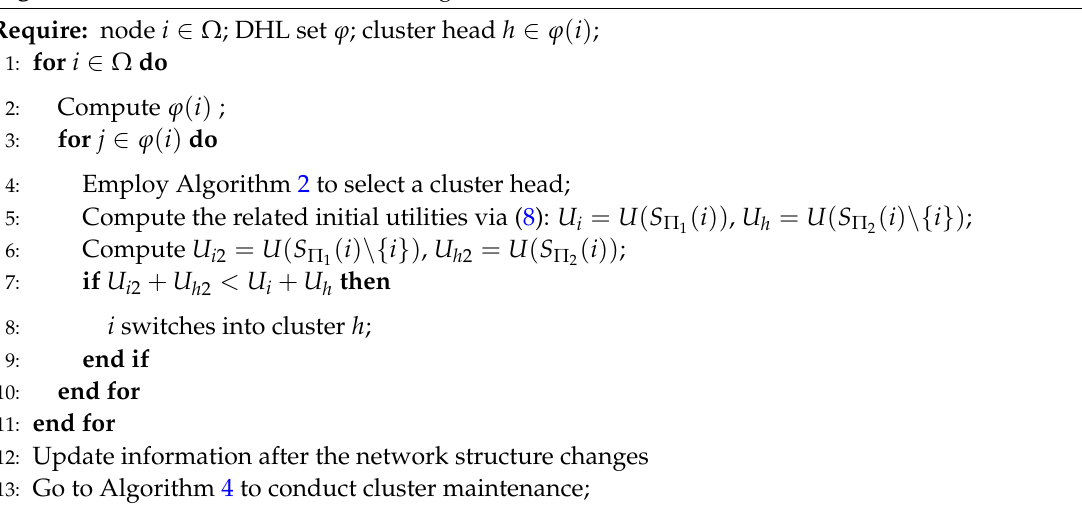
Algorithm 1 Switch rule-based